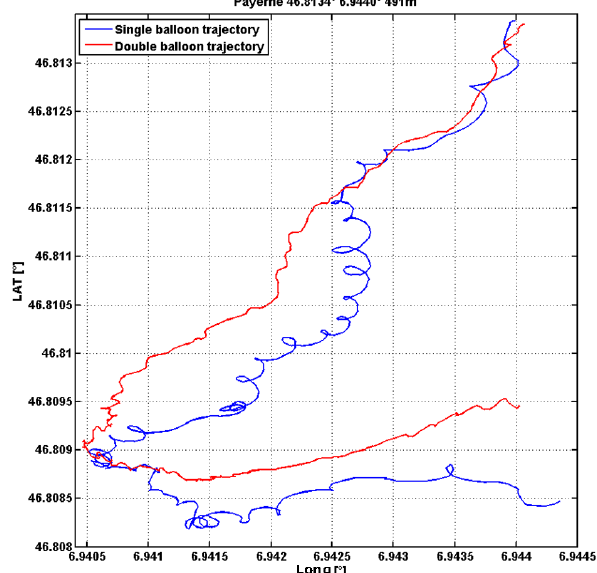
Figure 9. Horizontal trajectories of two radiosonde flights launched simultaneously at Payerne, Switzerland, on 12 May 2011. The two curves show the GPS latitude and longitude coordinates over the first 2000m of ascent for the standard single balloon configuration (blue) and the double balloon configuration (red). Circles of up to 10m radius in the single balloon radiosonde’s trajectory show the pendulum motion of the payload that is absent in the double balloon radiosonde’s trajectory.